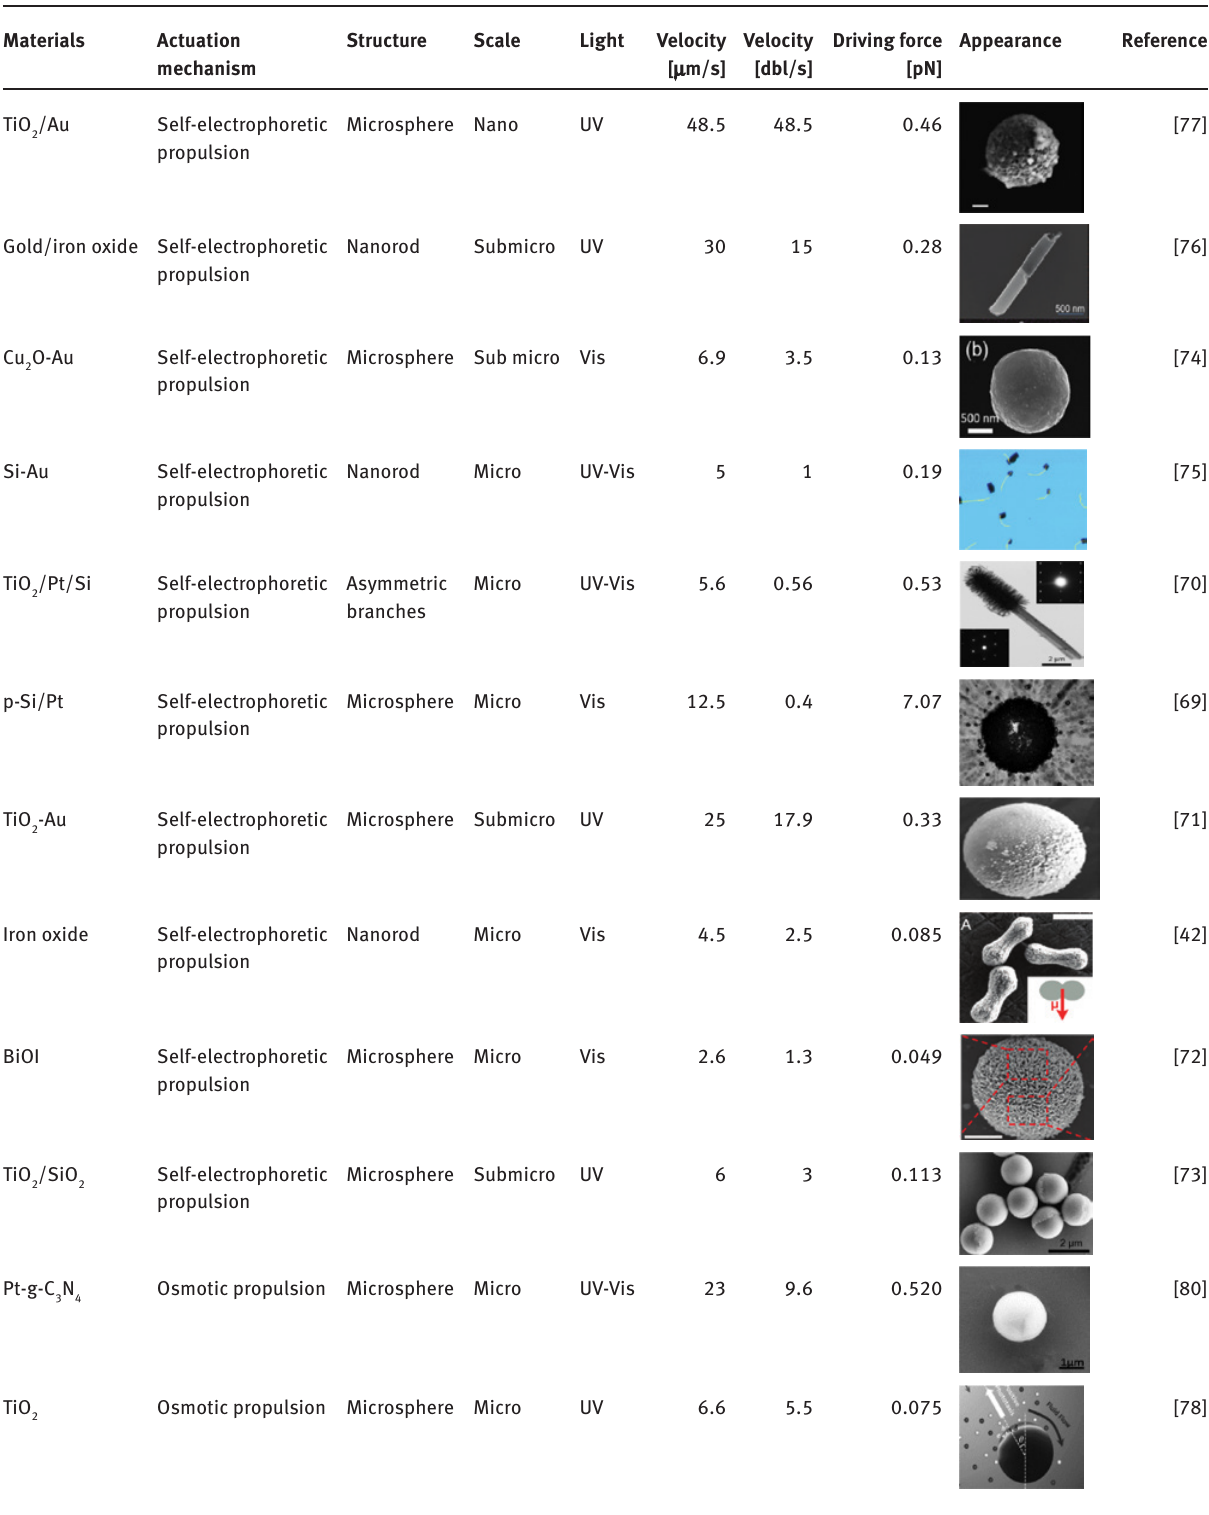
Table 4: Comparison of motion velocity and estimated driving force for light-driven micro/nanomotors through self-electrophoretic propulsion and osmotic